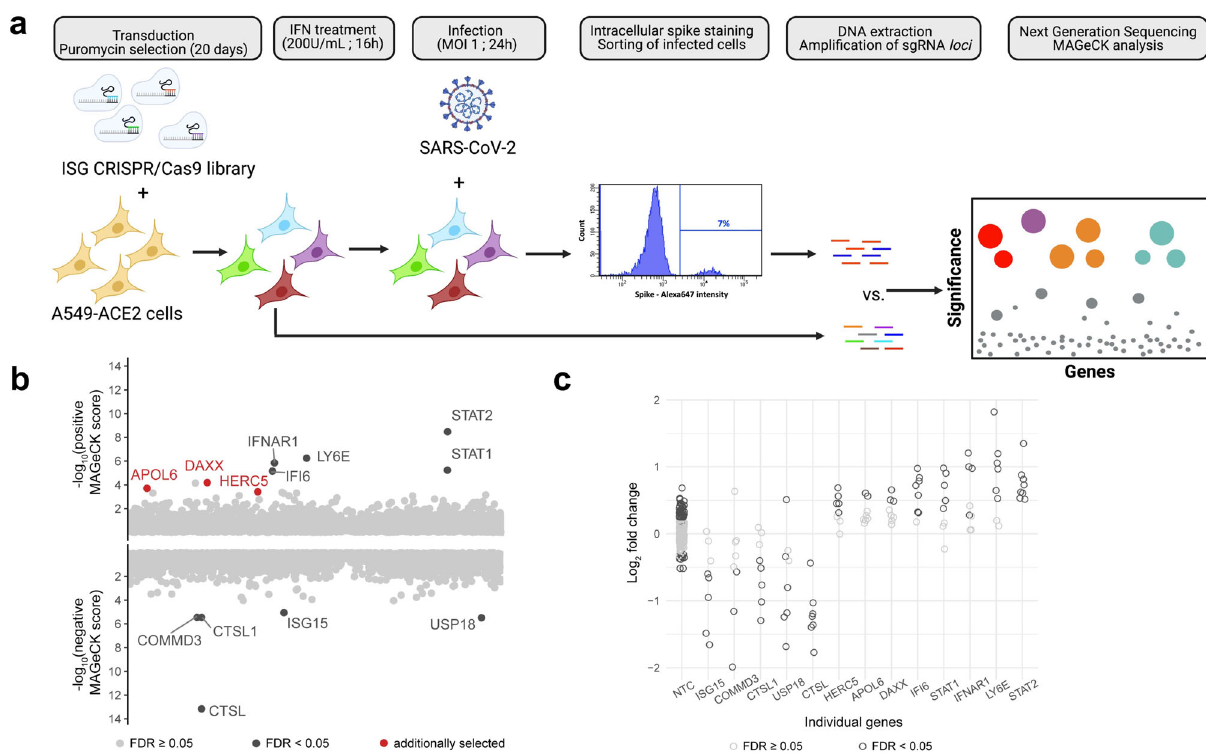
Fig. 1 ISG-focused CRISPR/Cas9 screening approach to identify restriction factors for SARS-CoV-2. a CRISPR/Cas9 screen outline. A549-ACE2 cells were transduced with lentivectors encoding the ISG CRISPR/Cas9 library and selected by puromycin treatment for 20 days. Library cells were then pre- treated with 200 U/mL of IFN α for 16 h, and infection with SARS-CoV-2 at an MOI of 1. At 24 h p.i., infected cells were fi xed with formalin treatment, permeabilized by saponin treatment and stained with a monoclonal anti-spike antibody. After secondary staining, infected cells were sorted and harvested. Non-infected, non-IFN α treated cells were harvested as a control. DNA was extracted from both cellular fractions and sgRNA loci ampli fi cation was carried out by PCR. Following NGS, bio-informatic analysis using the MAGeCK package was conducted. This fi gure was created with BioRender.com. b Screen results. By taking into account the enrichment ratios of each of the 8 different sgRNAs for every gene, the MAGeCK analysis provides a positive score for proviral factors, represented in the bottom portion of the graph). Genes with an FDR < 0.05 are represented in black. 3 genes with a FDR > 0.05, but with a